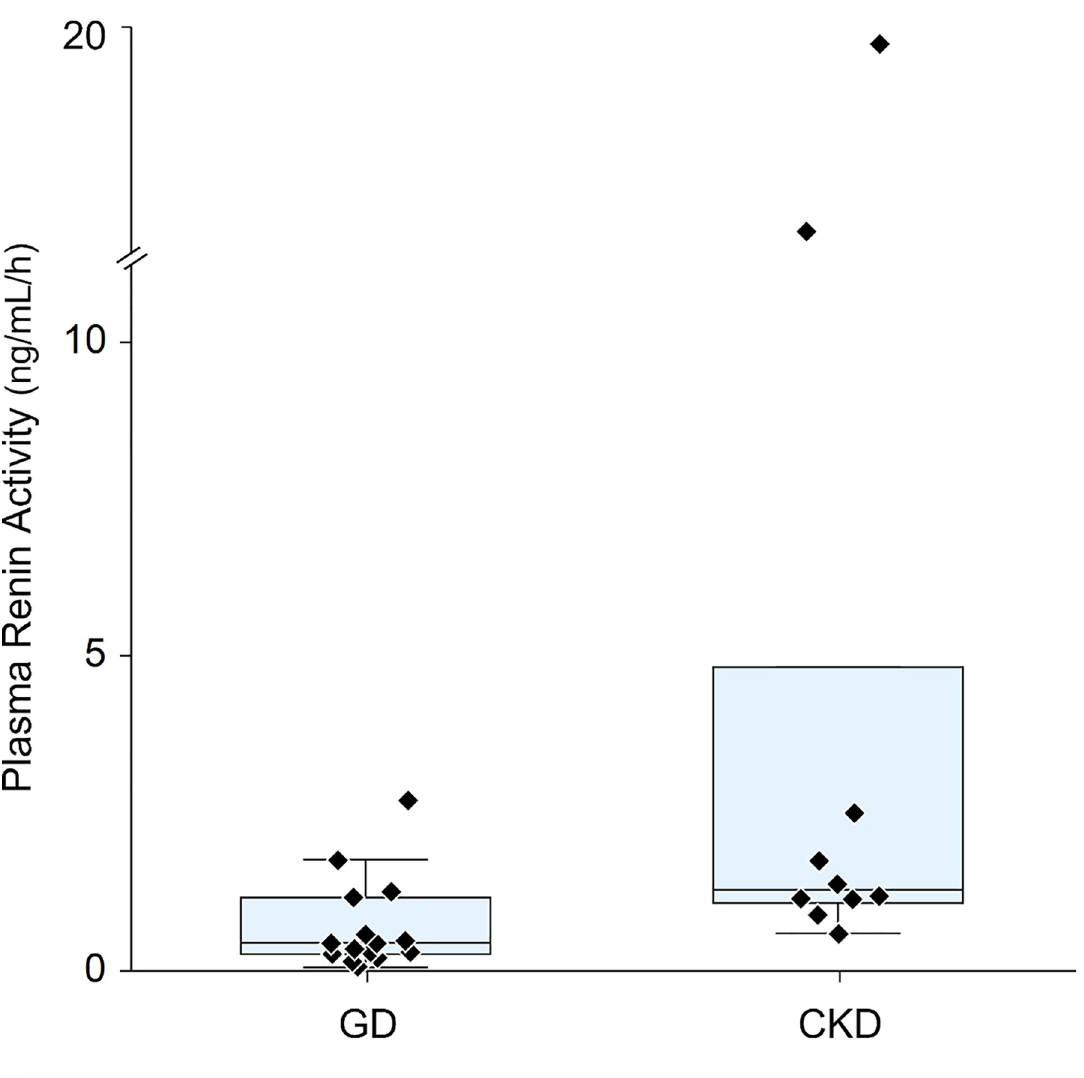
Fig 2. Plasma renin activity. GD = Glomerular disease, CKD = chronic kidney disease. Each diamond represents 1 dog. (Table 3): LA:Ao was normal in all 25 dogs; LVDd in 14/15 dogs with GD (93%) and 8/10 dogs with CKD (80%). The additional laboratory variables were not different between the groups (Table 3). Interestingly, NT-proBNP was elevated in 18/25 dogs without echocardiographic evidence of cardiac disease or volume overload. The FE was neither correlated with the PRA Na (r 2 = 0.01, p = 0.70) nor with the serum aldosterone concentration (r 2 = 0.01, p = 0.67). Two dogs with GD (13%) were clinically tachycardic, 4 (27%) had weak pulses, 3 (20%) a prolonged CRT, and 4 (27%) cold extremities. Consequently, 8 dogs (53%) were classified as clinically hypovolemic and 7 (47%) non-hypovolemic. Three dogs had clinical signs of dehy- dration with a decreased skin turgor. Three dogs showed signs of overhydration (20%): periph- eral edema (n = 2), gelatinous skin (n = 2), and ascites (n = 1). Three dogs (20%) were therefore classified as dehydrated, 3 (20%) overhydrated and 9 (60%) euhydrated. Hydration